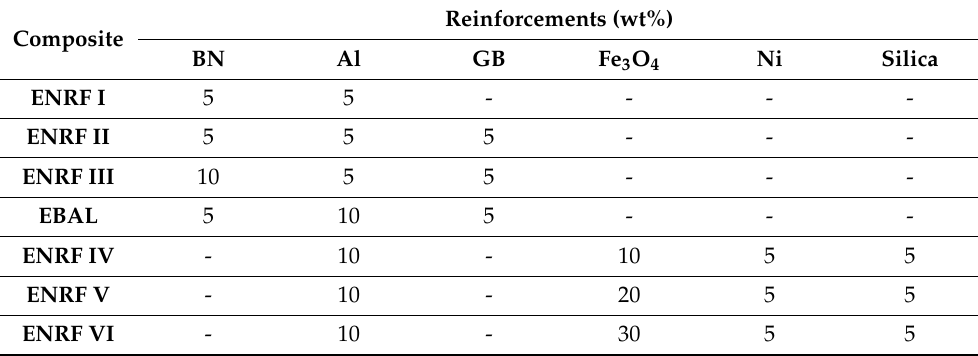
Table 5. Composition of the epoxy-rubber based composites reinforced with GBs, aluminum, boron, and Fe 3 O 4